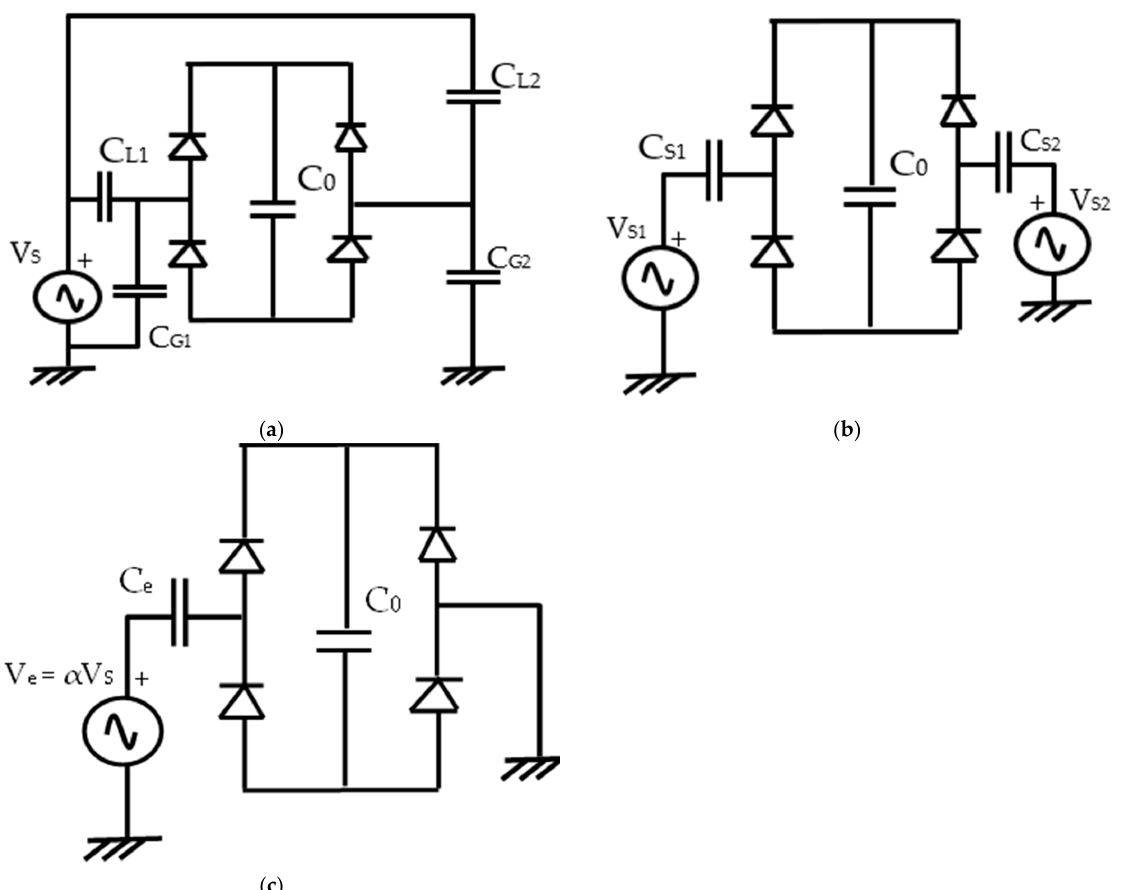
Figure 3. ( a ) The circuit representation of Figure 2. ( b ) Thevenin’s equivalent circuit of the source and the stray capacitors for the metal plates. ( c ) The final equivalent circuit by combining the voltage sources and the stray capacitors. Similarly, the stray capacitances from the metal plate 2 to the power line and the